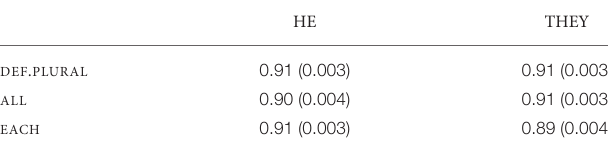
TABLE 6 | The proportion of correct responses (SE), Experiment